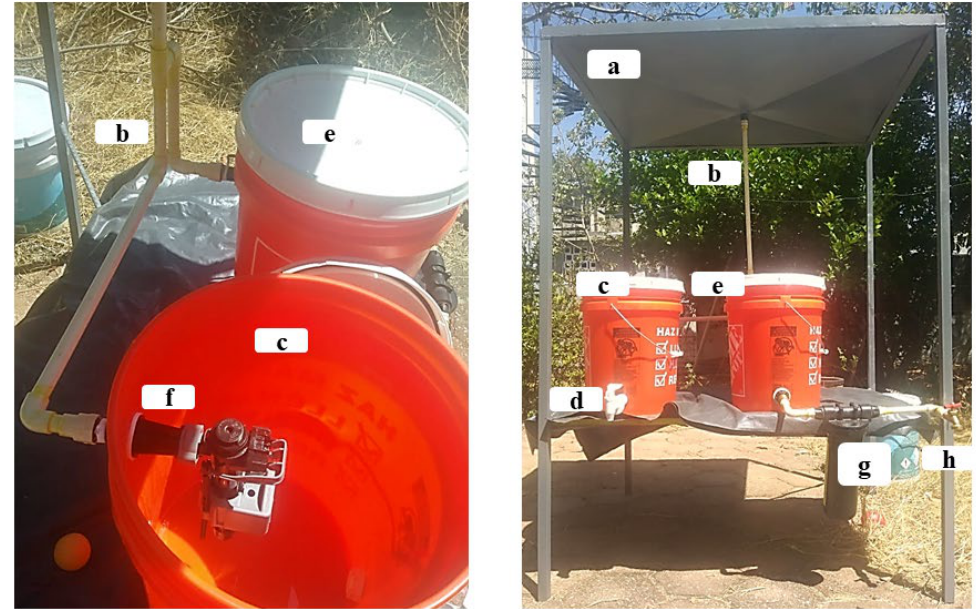
Figure 5. In situ rainwater harvesting sampling system. ( a ) Catchment surface area; ( b ) conveyance; ( c ) first-rain separator; ( d ) separated effluent outlet; ( e ) rainwater storage; ( f ) Kerick valve; ( g ) filter; ( h ) treated effluent outlet.